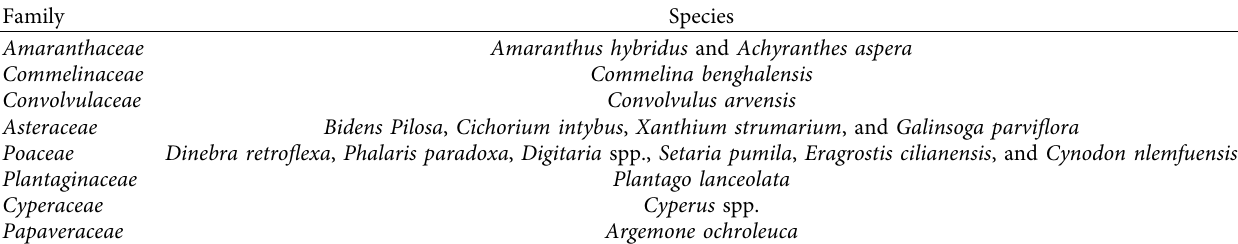
Table 2: The major broadleaf and grass weed species observed during the experimental season.